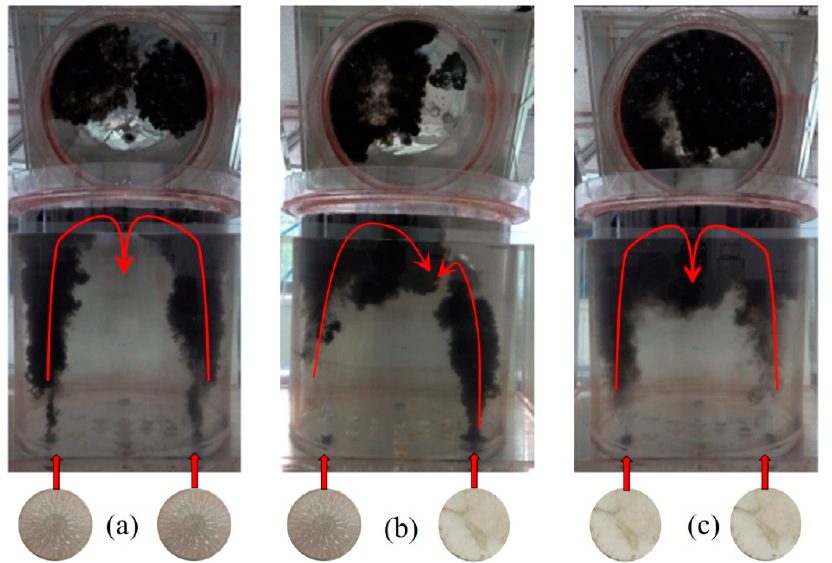
Figure 8. The characteristics of flow field with different bottom stirring mode traced by ink: ( a ) S-S mode, ( b ) S + P mode, and ( c ) P-P mode.